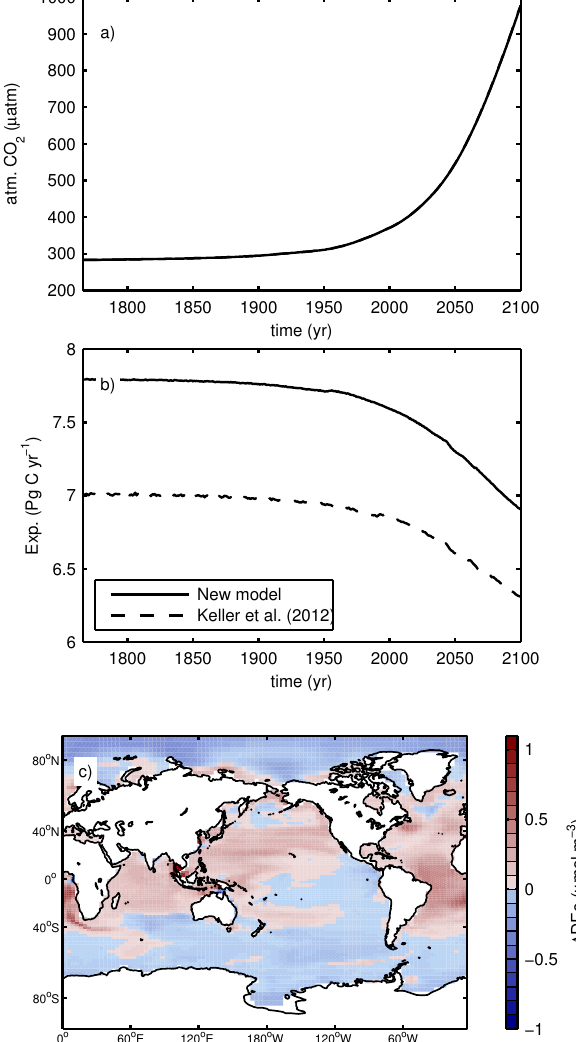
Figure 21. Results of the global warming scenario run following the high-CO 2 emissions representative concentration pathway (RCP 8.5) scenario: (a) Annual average CO 2 concentrations with the new model and with the model by Keller et al. (2012) (not distinguish- able), (b) globally integrated export production at 80m with the new model and with the model by Keller et al. (2012), (c) the difference in surface dissolved iron concentrations between the year 2100 and year 1765.